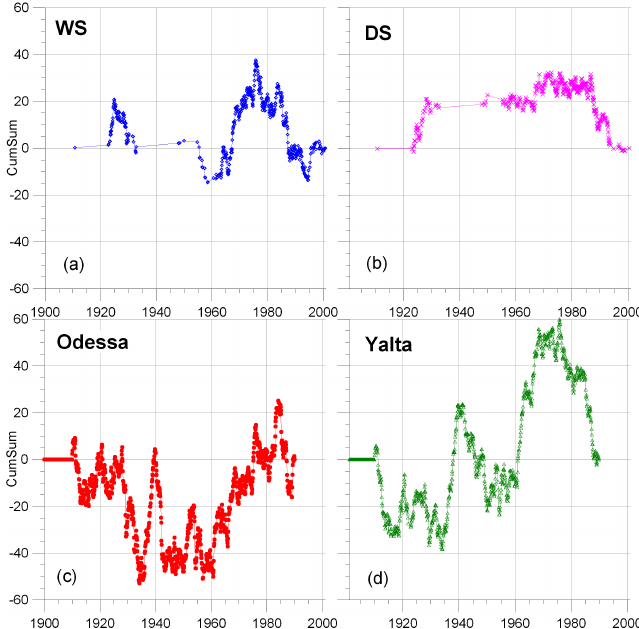
Fig. 8. The CUMSUM charts for aggregated temperature anomalies on the western shelf (a) and deep sea (b) , and the CUMSUM charts for air temperature anomalies at coastal stations Odessa (c) and Yalta (d) .